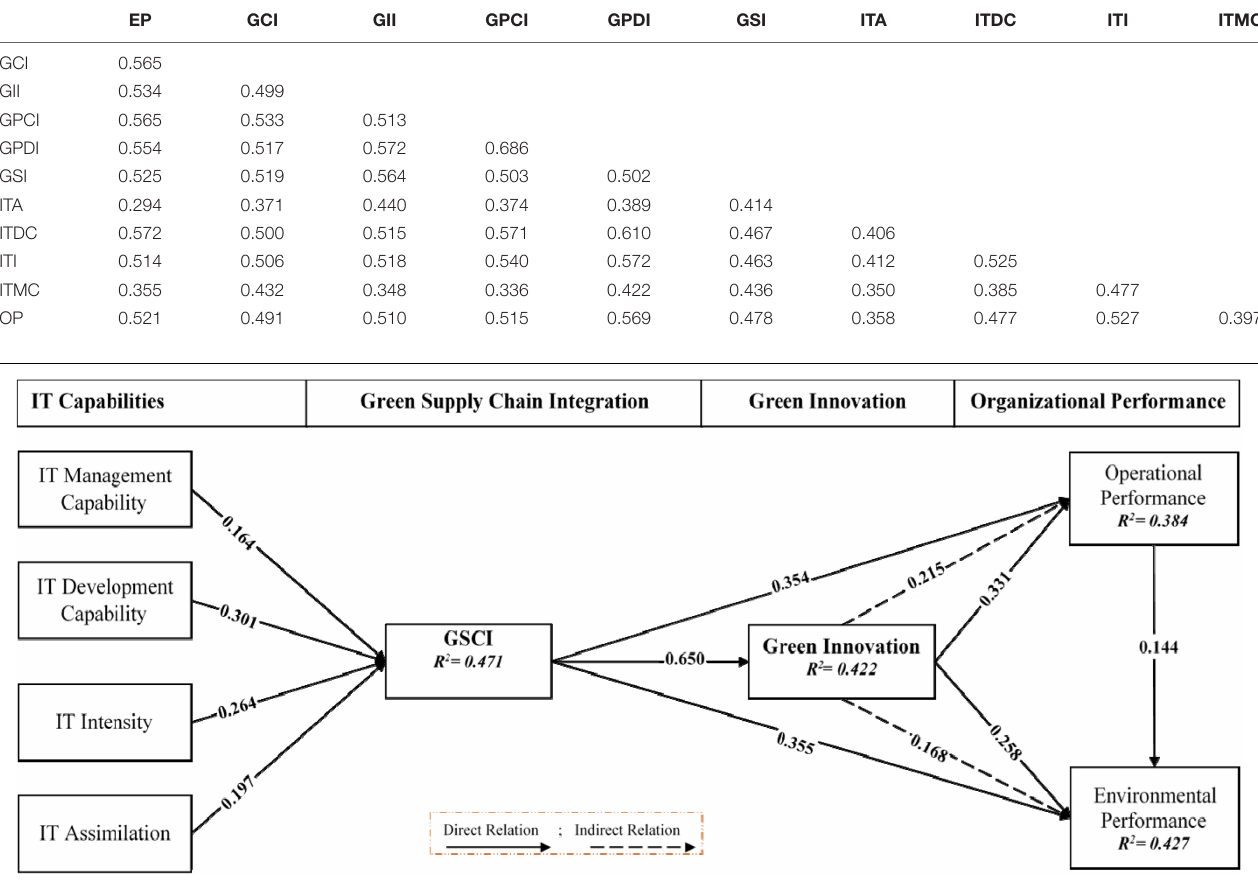
TABLE 5 | HTMT ratio criterion.